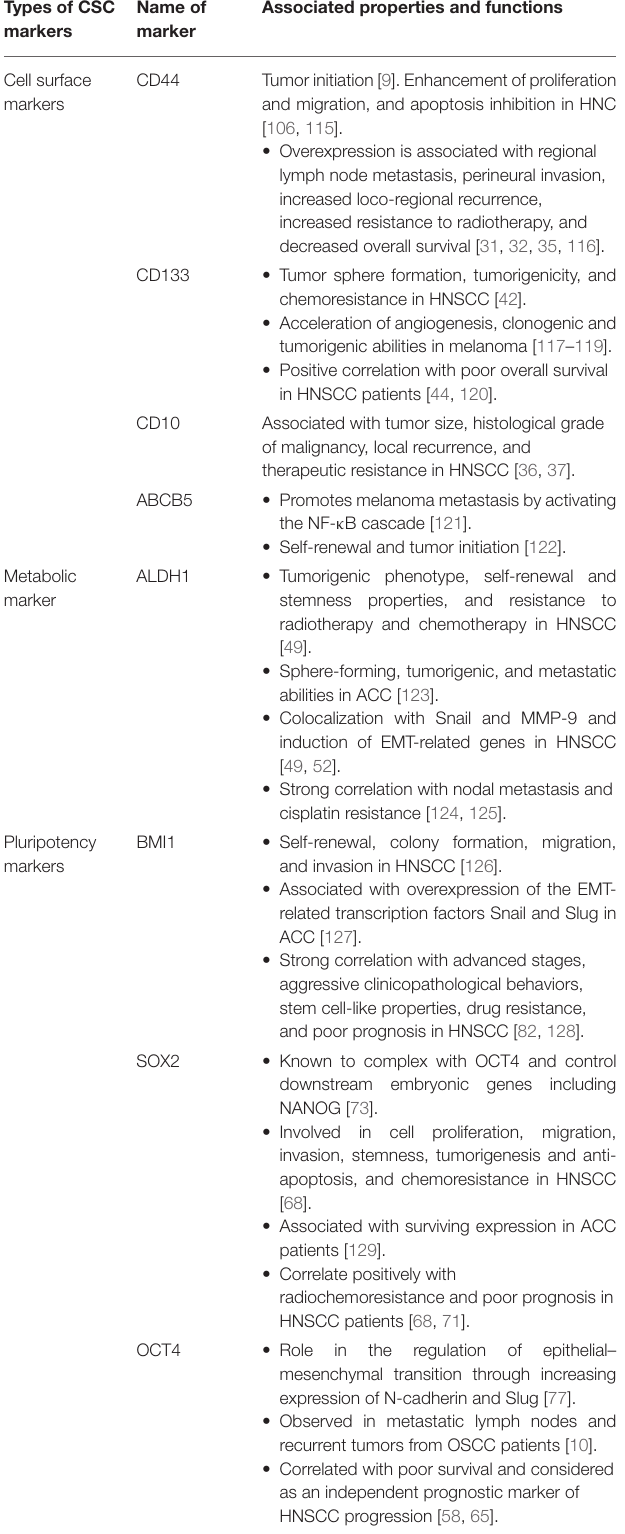
TABLE 1 | CSC markers in HNCs. Different markers for the identification and characterization of CSCs in HNCs, including HNSCC, ACC, MEC, and oral melanoma are